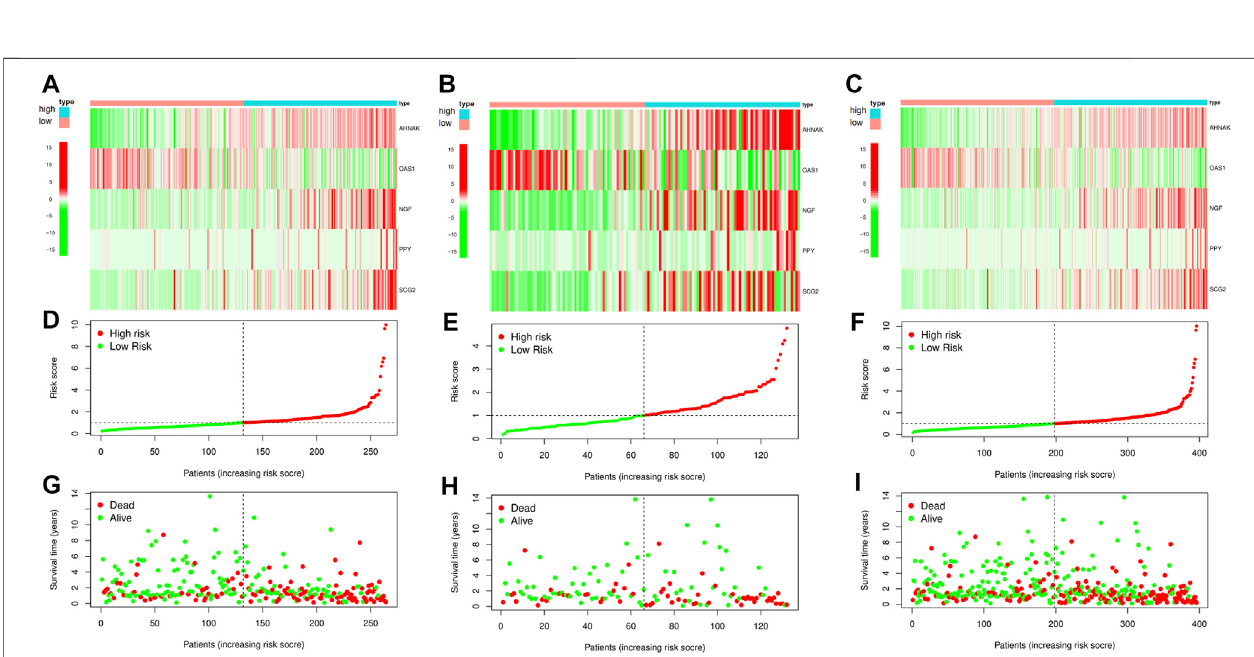
FIGURE4| Construction and cross-validation ofbladderurothelialcarcinoma (BLCA) prognostic model. (A – C) The heatmap showingthe expression levels ofthe key immune-related differentially expressed genes (DEGs) in the prognostic model for each sample in the training set, test set and combined set, respectively. (D – F) Distribution of risk scores (RSs) for each sample in three different datasets. (G – I) Distribution of survival states for each sample in three different datasets.